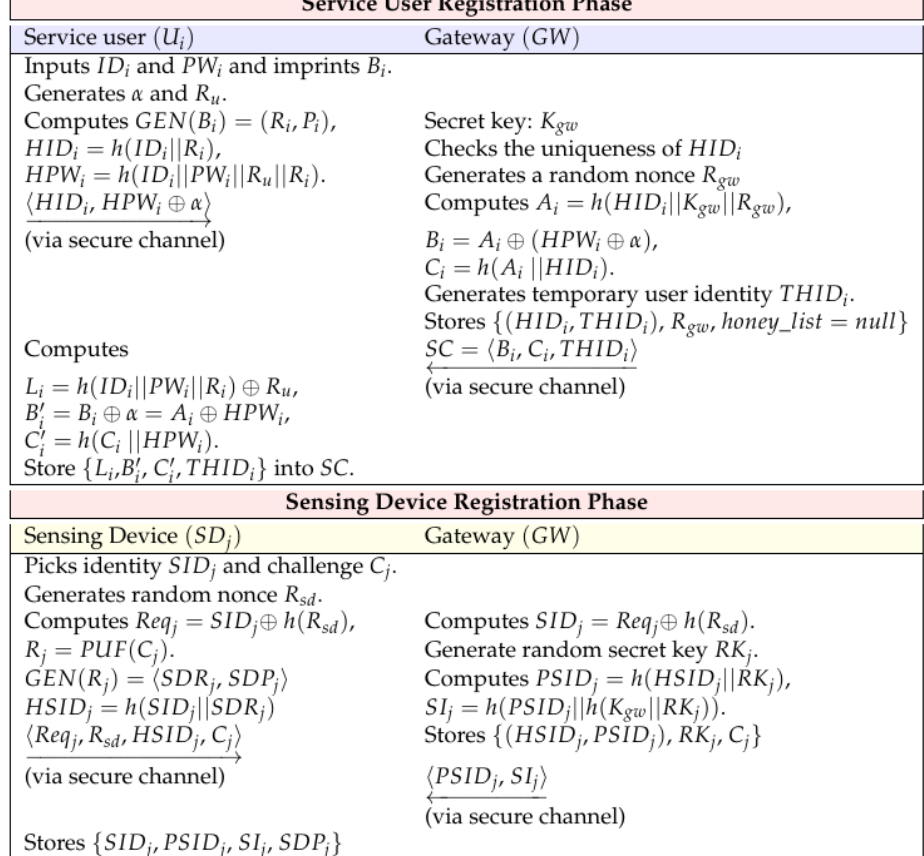
Figure 2. Registration